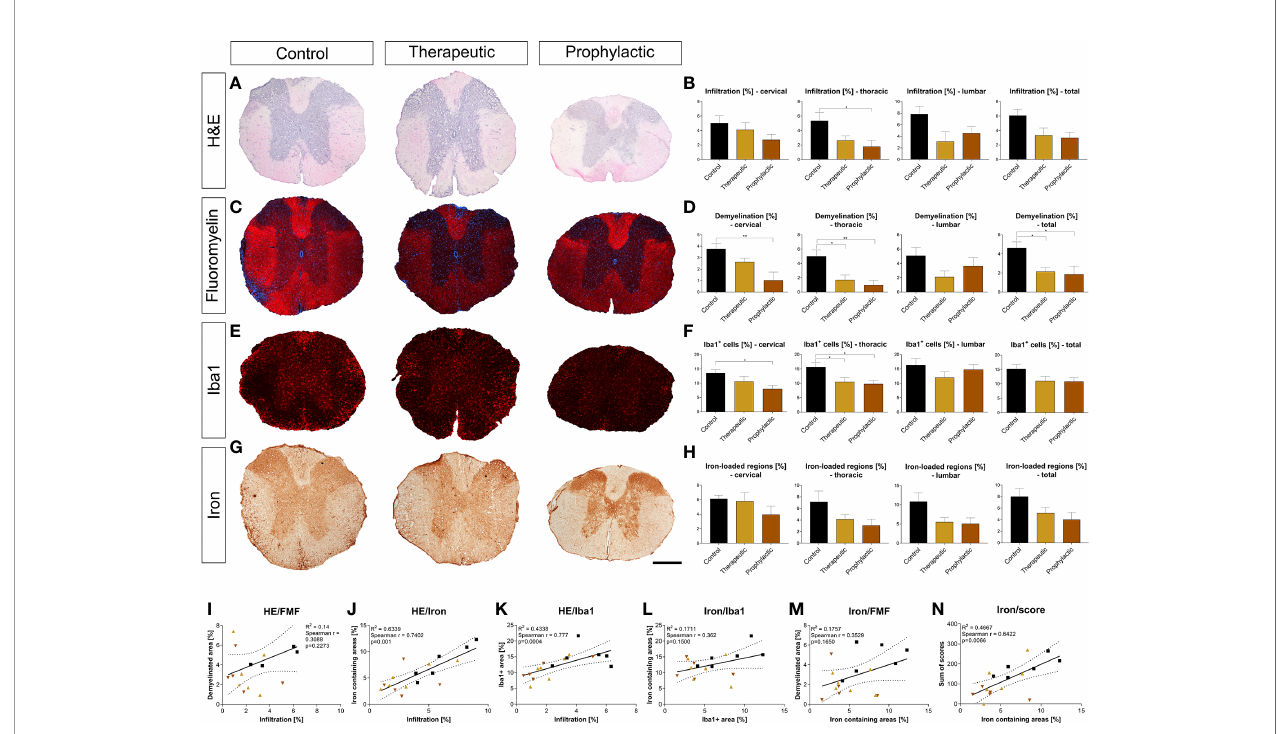
FIGURE 5 | Prophylactic and therapeutic clozapine administration reduce in fi ltration of in fl ammatory cells, iron loaded regions, demyelination and microglia activation in spinal cord sections. (A) Representative images of H&E stained spinal cord sections. (B) Clozapine administration led to a trend towards decreased in fi ltration in all spinal cord segments, reaching signi fi cance in thoracic segments of the spinal cord in prophylactically treated mice (p=0.0427). (C) Representative images of fl uoromyelin stained spinal cord sections. (D) Demyelination of total spinal cord sections was signi fi cantly reduced after both symptomatic (p < 0.05) and therapeutic administration (p < 0.05). (E) In fi ltration of macrophages/microglia, as assessed using Iba1 staining. (F) Less in fi ltration in cervical and thoracic cord in prophylactic treated mice (p < 0.05), lacking signi fi cance upon analysis of the whole spinal cord. (G) Representative images of iron stained sections. (H) Trend towards less iron deposition in all sections, lacking signi fi cance. (I) While in fi ltration and demyelination as well as (L) iron deposition and macrophage/microglial in fi ltration and (M) iron deposition and demyelination did not correlate, (J) there was a strong correlation of in fi ltration and iron deposition (Spearman r = 0.74; p = 0.001), (K) general in fi ltration and microglial/macrophage in fi ltration (Spearman r = 0.77; p = 0.0004) as well as (N) iron deposition and individual animal score (Spearman r = 0.64; p = 0.0066). (B, D, F, H) Ordinary one-way ANOVA and Dunnett ’ s multiple comparison with a single pooled variance and 95% con fi dence interval. (I-N)